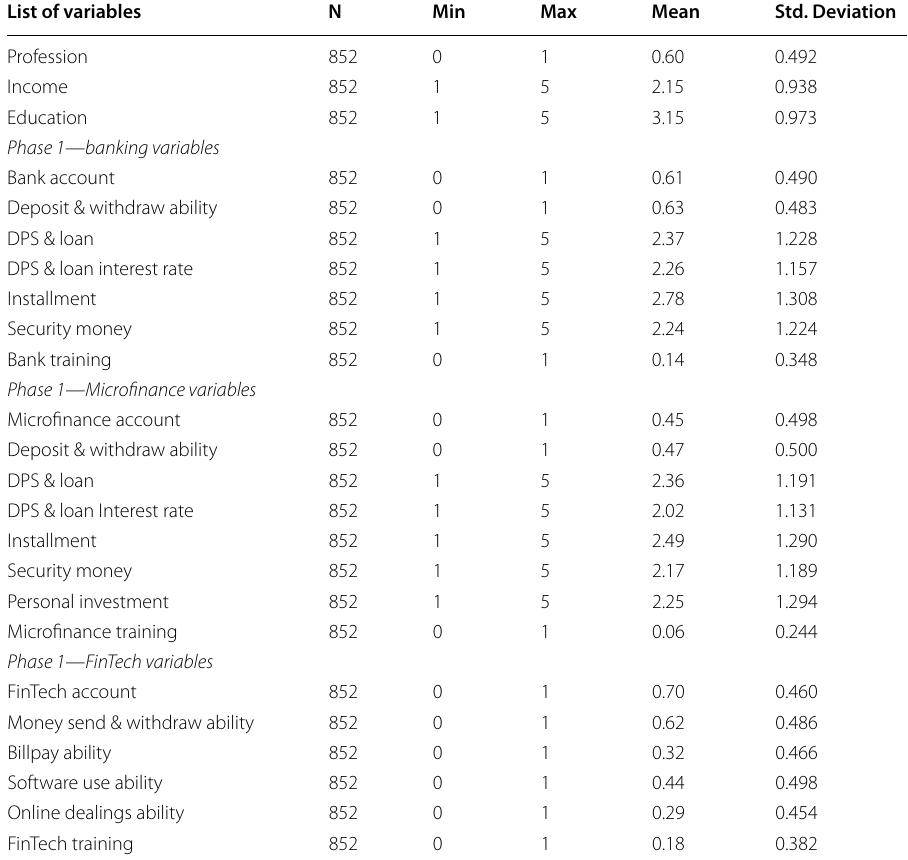
Table 4 Descriptive statistics. Source : Author’s findings List of